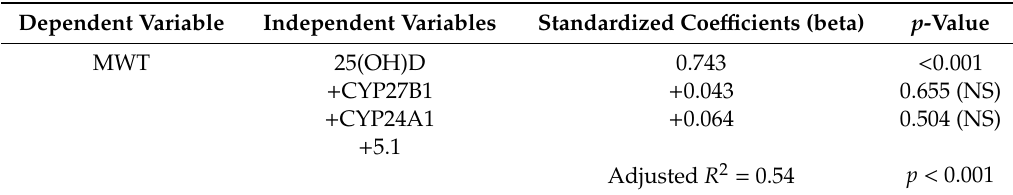
Figure 1. Trabecular and cortical bone structural variables across 25-dihydroxyvitamin D3 (25(OH)D intervals with ( A ) BV / TV (bone volume / tissue volume), ( B ) Tb.N (trabecular number) and ( C ) Tb.th (trabecular thickness), ( D ) MWT (mean wall thickness), ( E ) BS / BV (bone surface / bone volume), ( F ) cortical thickness, ( G ) femoral diameter and ( H ) medullary width. Mean +/ − SEM; n = 103; * p < 0.05 vs. 10–30 nmol / L serum 25(OH)D interval. Table 4. Multiple linear regression analyses for serum 25(OH)D, CYP27B1 and CYP24A1mRNA levels as determinants of Mean Wall Thickness.